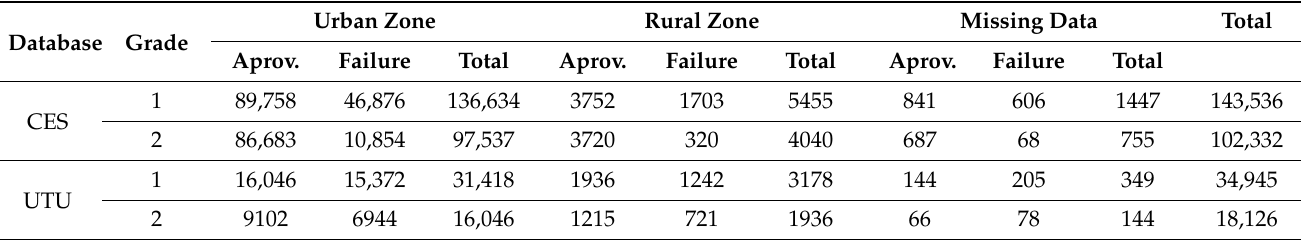
Table 4. Number of students in urban and rural areas for CES and UTU